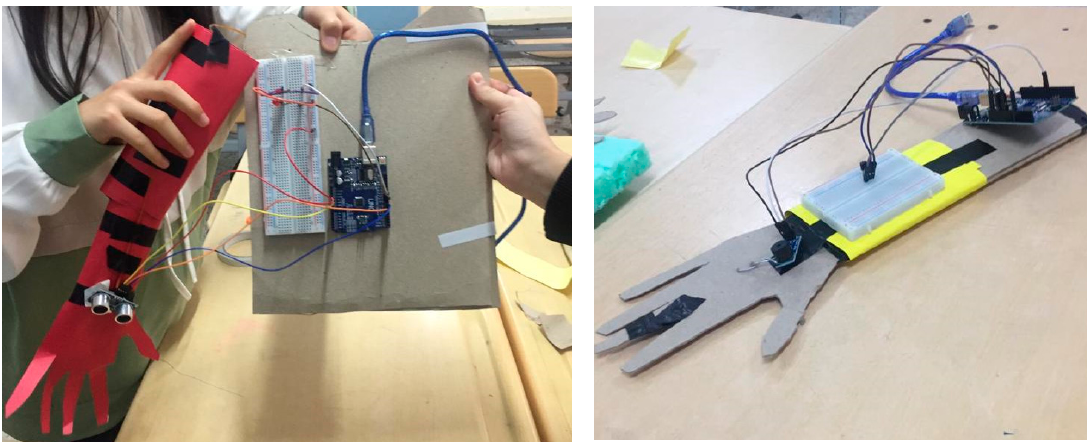
Figure 1. Bracelet model with a distance sensor.